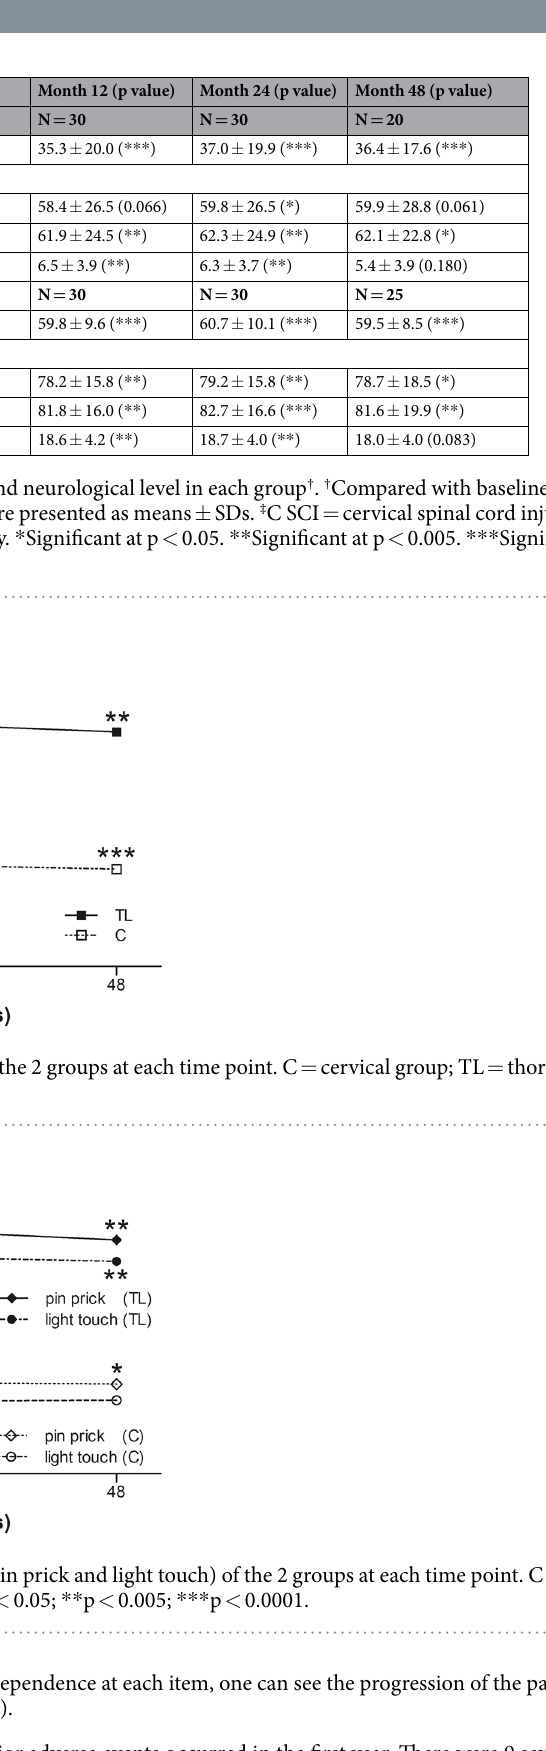
Major adverse events.